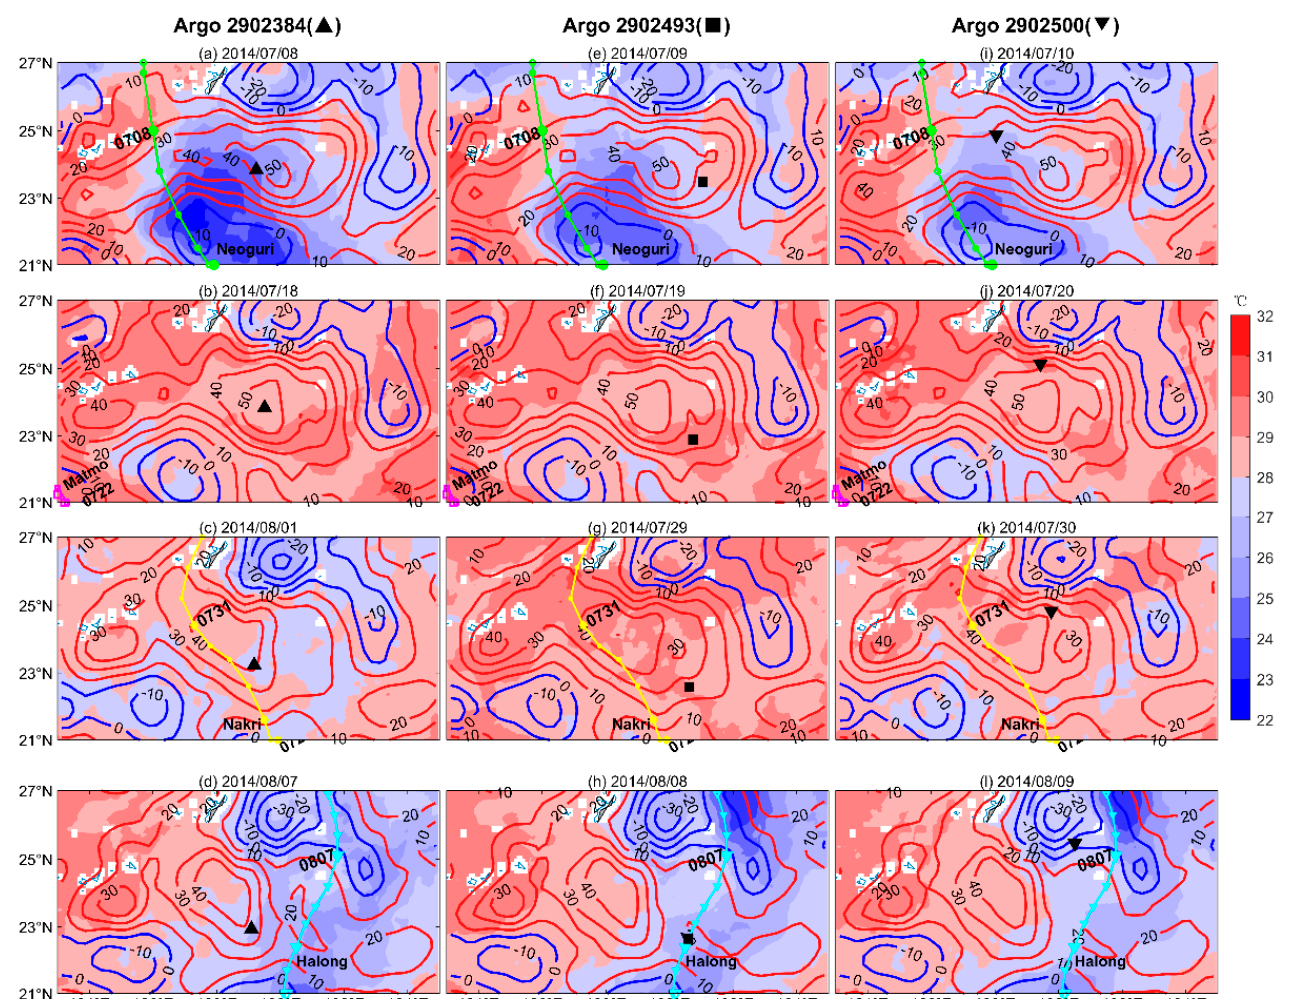
Figure 7. Times and positions of Argos 2902384 (a-d), 2902493 (e-h) and 2902500 (i-l) in the AE.